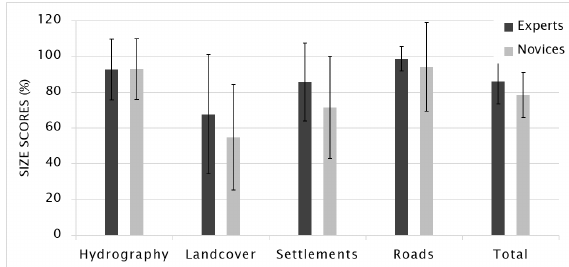
Figure 10. Size scores (Error bars indicate standard